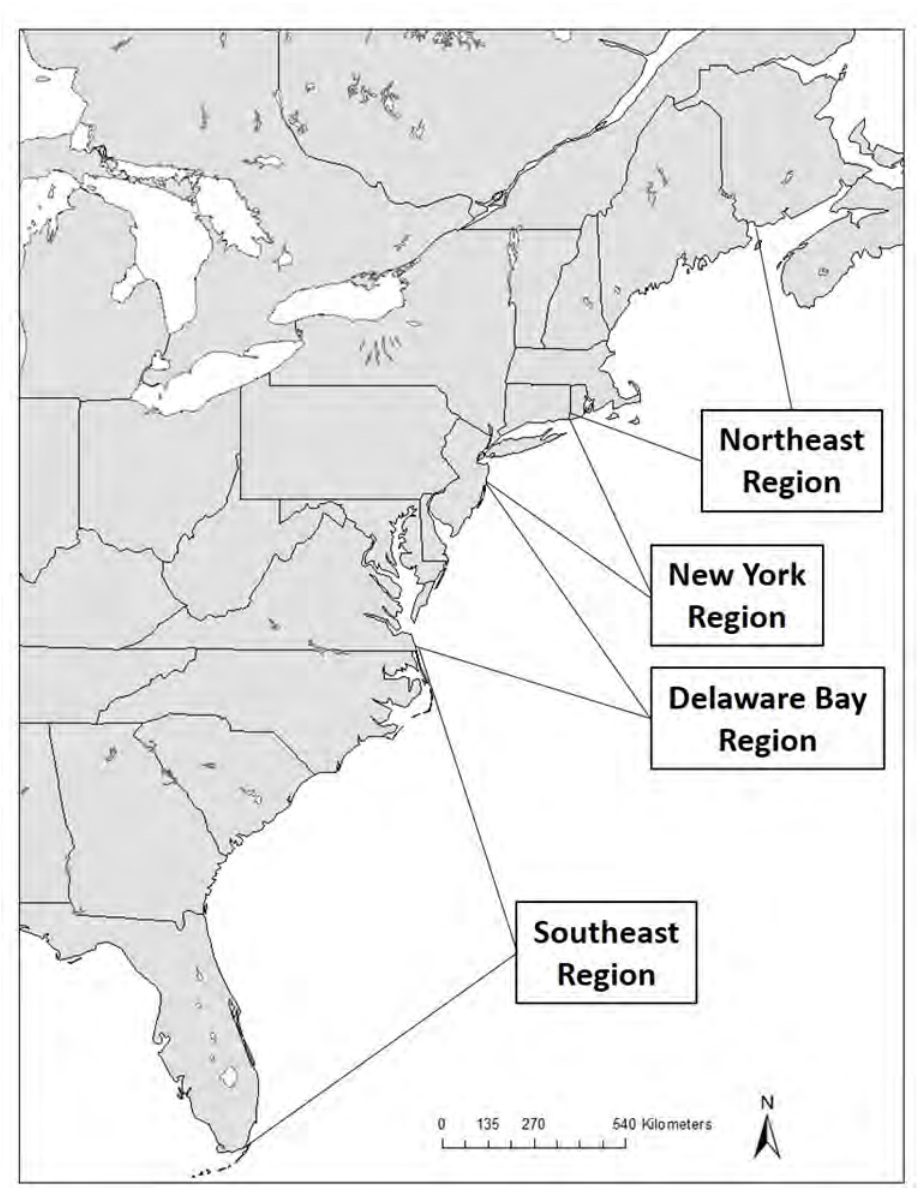
Figure 2. Map of the Atlantic coast showing the regions for horseshoe crab